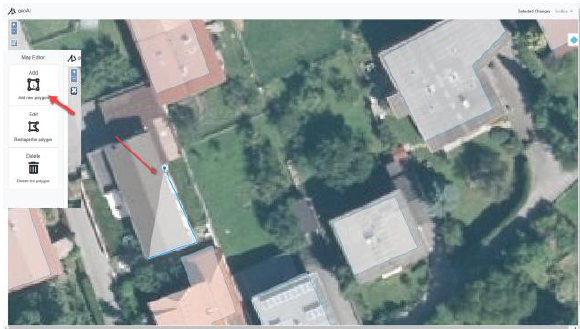
Figure 12. Map drawing tool on the WebGIS interface for the missing building.